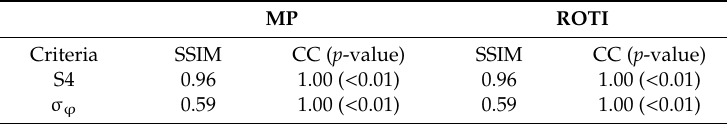
Table 7. SSIM and CC between the maps shown in Figure 8a.